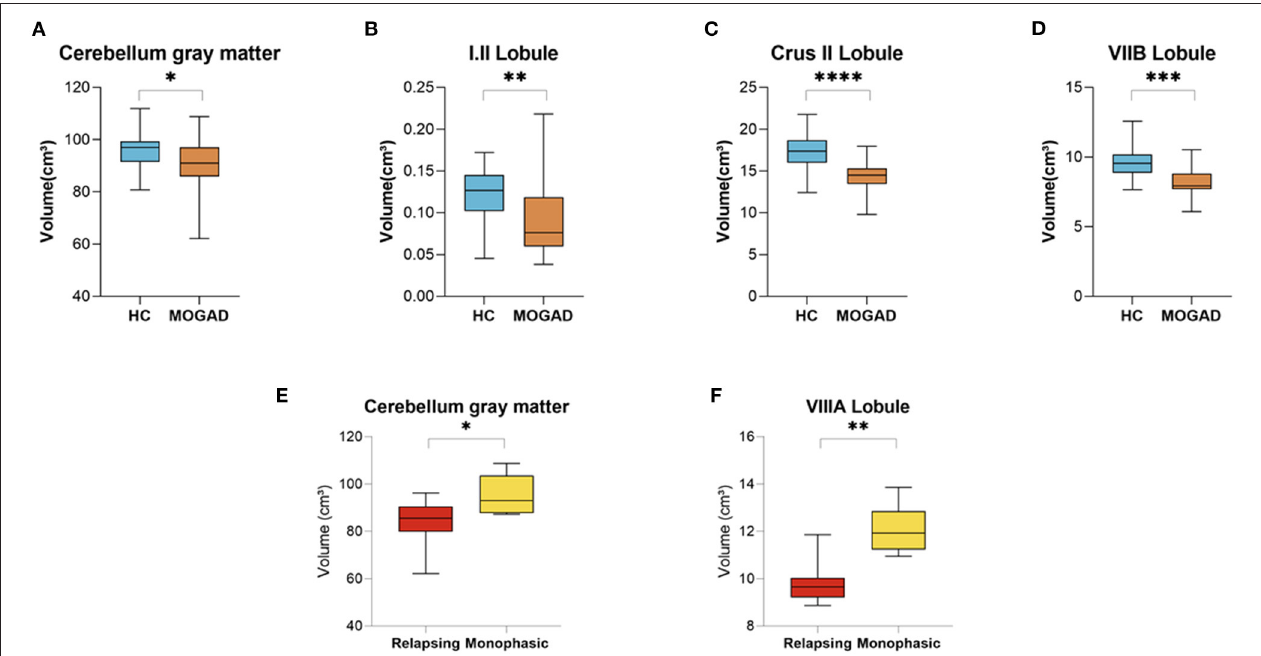
FIGURE 5 | Decrease volume of cerebellar lobules at MOGAD patients compared to HCs and decreased volume of cerebellar lobules at relapsing MOGAD patients compared to monophasic MOGAD patients. (A–D) Volume of cerebellar lobules of HCs ( n = 22) and MOGAD patients ( n = 20) analyzed by CERES pipeline of Volbrain software. Volume of (A) total cerebellum gray matter (96.23 ± 6.89 vs. 90.66 ± 10.43, p = 0.050), (B) cerebellar lobules I.II (0.12 ± 0.03 vs. 0.09 ± 0.05, p = 0.009), (C) Crus II (17.33 ± 2.18 vs. 14.39 ± 1.75, p < 0.001), and (D) VIIB (9.70 ± 1.24 vs. 8.26 ± 1.09, p < 0.001) of MOGAD patients and HCs. (E,F) Volume of cerebellar lobules of monophasic ( n = 6) and relapsing ( n = 6) MOGAD patients analyzed by CERES pipeline of Volbrain software. Volume of (E) total cerebellum gray matter (83.14 ± 10.78 vs. 95.34 ± 8.52, p = 0.047) and (F) cerebellar lobule VIIIA (9.87 ± 0.97 vs. 12.09 ± 1.03, p = 0.002) of monophasic and relapsing MOGAD